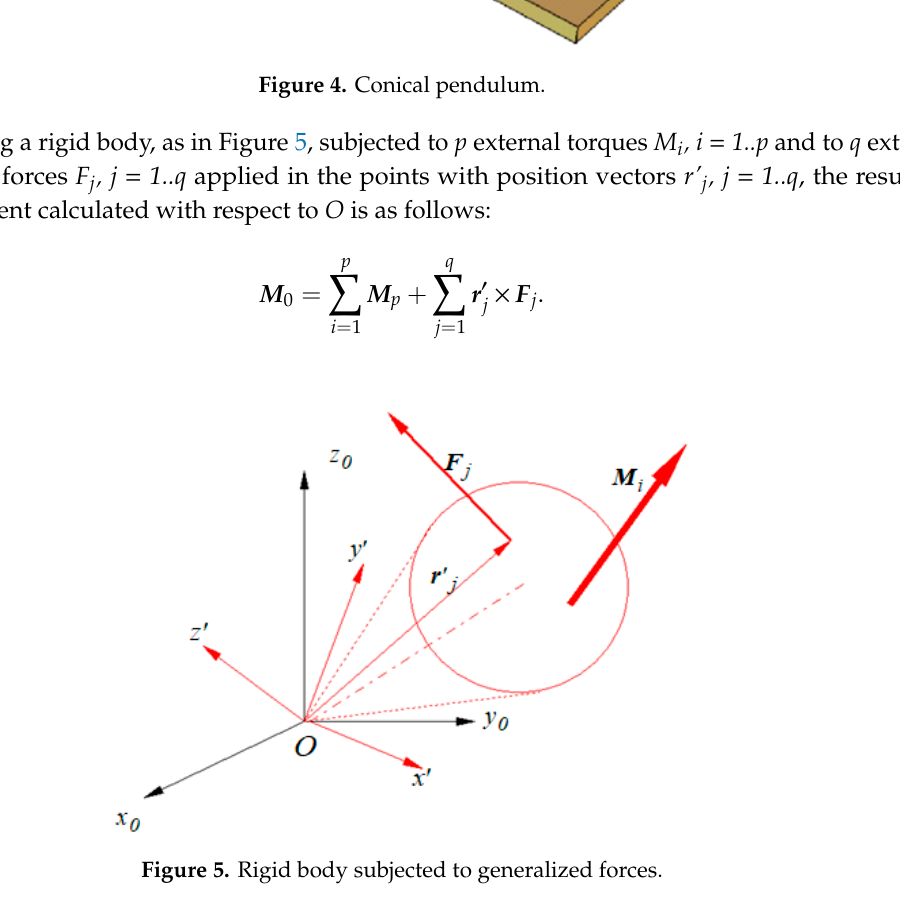
Figure 5. Rigid body subjected to generalized forces.